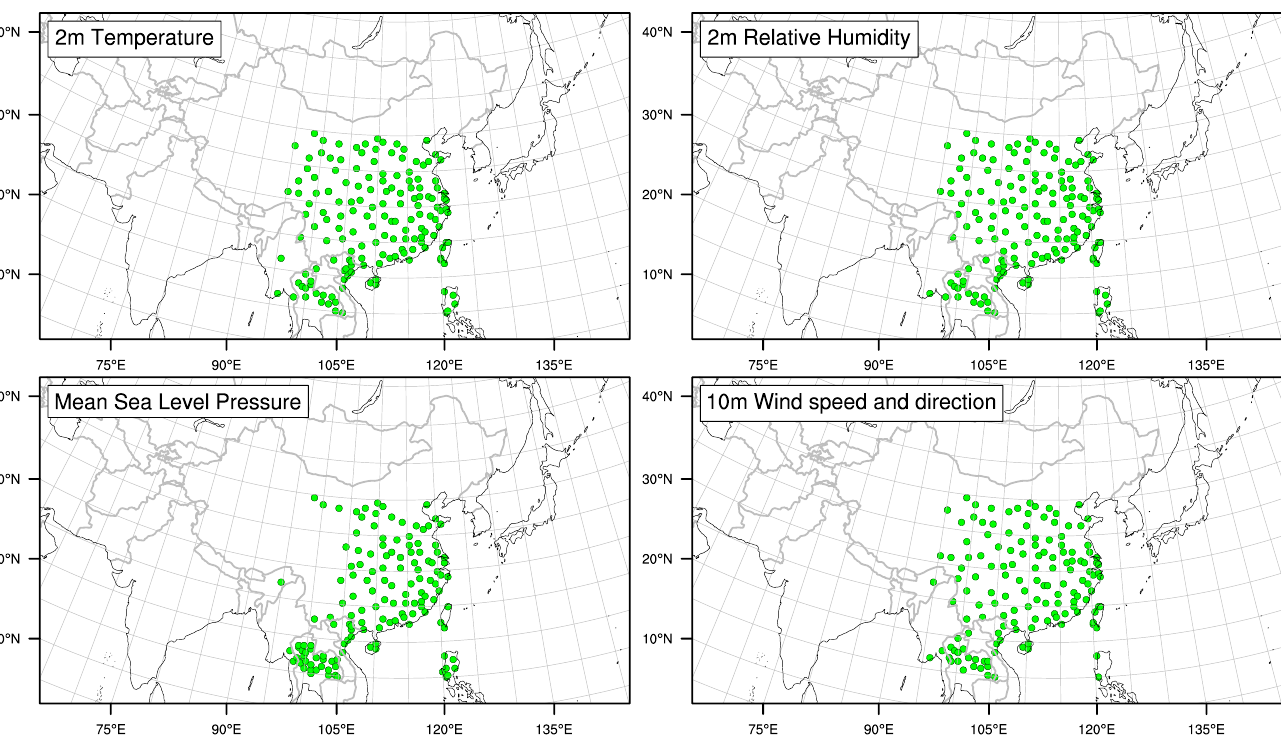
Figure 3. The distribution of the observation data that are used to evaluate the performance of the model of domain 1 (D1) for seasonal sensitivity forecast (Figure